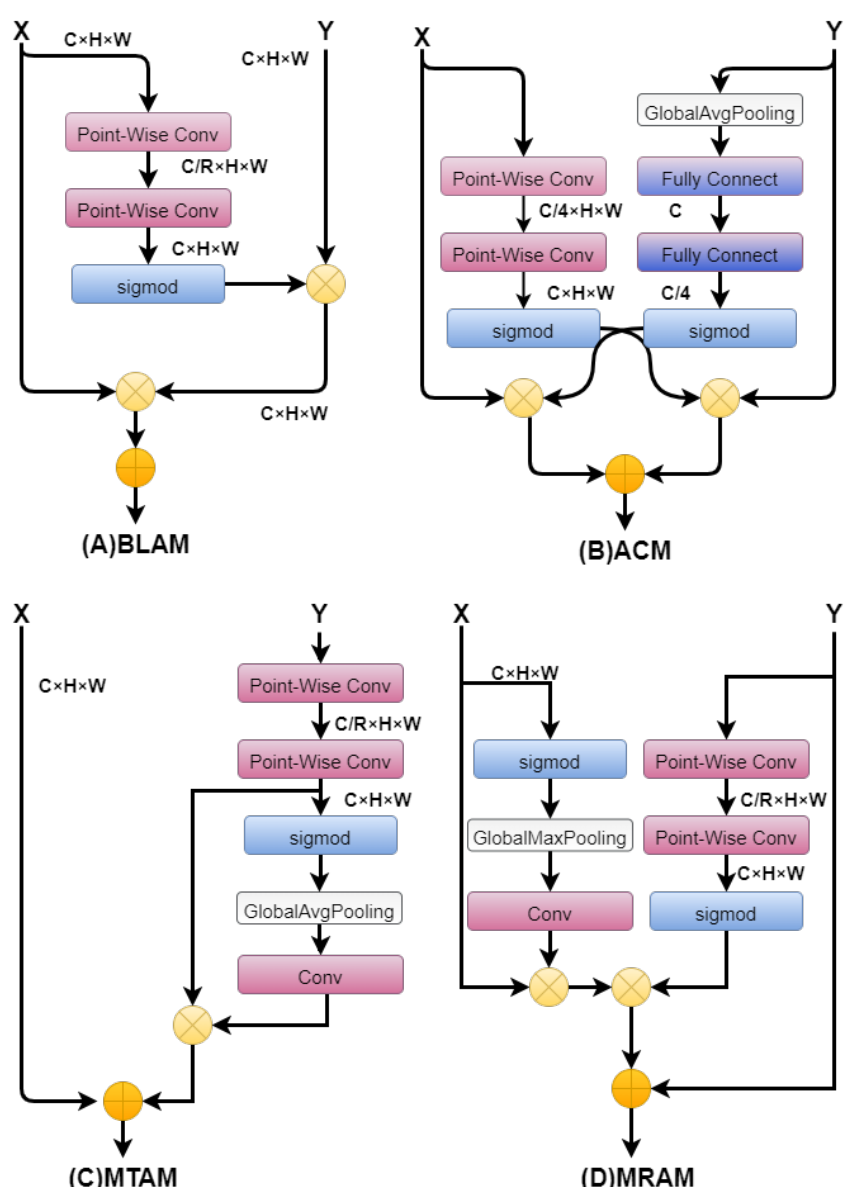
Figure 15. Architecture of various fusion modules. ( A ) Bottom-up attentional module (BLAM). ( B ) Asymmetric contextual modulation (ACM). ( C ) Multimechanism top-down attention mod- ules(MTAM). ( D ) Multimechanism reverse attention module